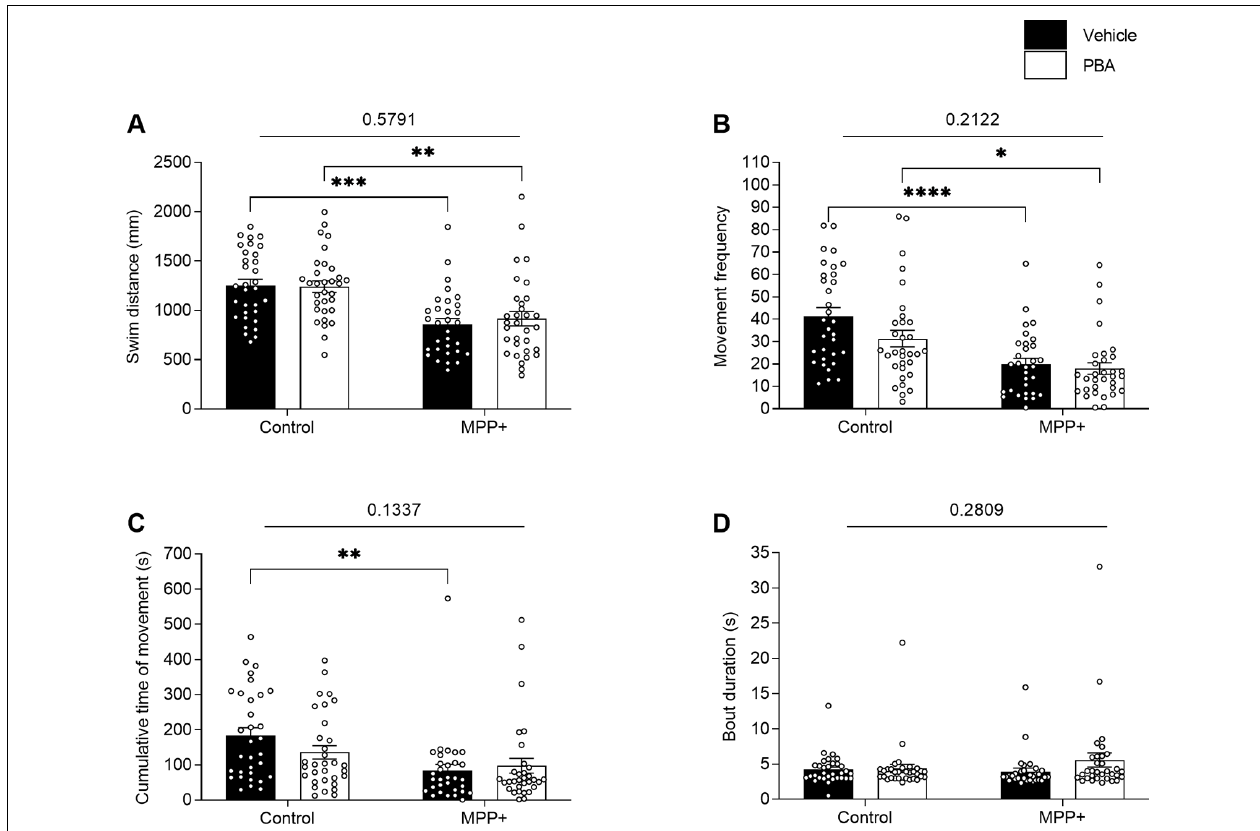
FIGURE 7 | Effects of 4-phenylbutyrate (PBA) on motor activity of MPP+-treated zebrafish larvae. Larvae in the absence (Control) or presence of 500 µ M MPP+ were treated with vehicle (black bars) or 100 µ M PBA (white bars). Motor activity was evaluated for (A) distance swum (mm); (B) frequency of movement; (C) cumulative time of movement (s) and (D) movement bout duration (s) during five consecutive light-on phases. Data are presented as means ± SEM from a single experiment, control group n = 32, MPP+ group n = 31, PBA group n = 32, MPP+/PBA group n = 32. Normality was tested using D’Agostino and Pearson